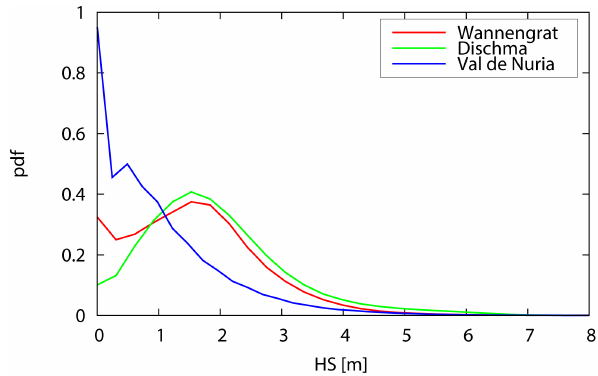
Figure 2. Probability density functions (pdf) of measured snow depths are shown for the three